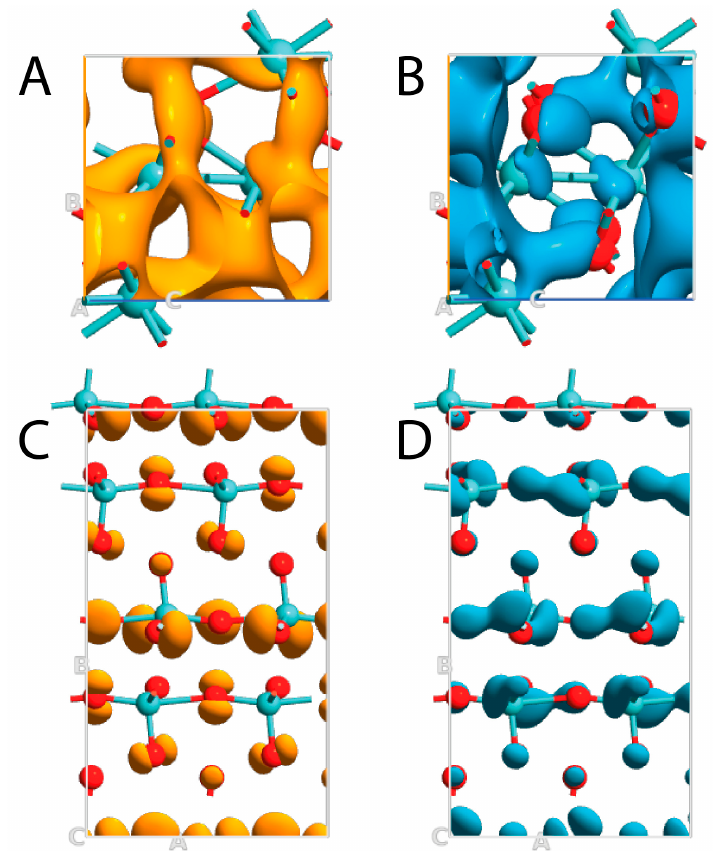
Figure 5. HOMO–LUMO representation of MoO 2 ( A , B ) and MoO 3 ( C , D ). HOMO and LUMO are reported in orange and blue, respectively.